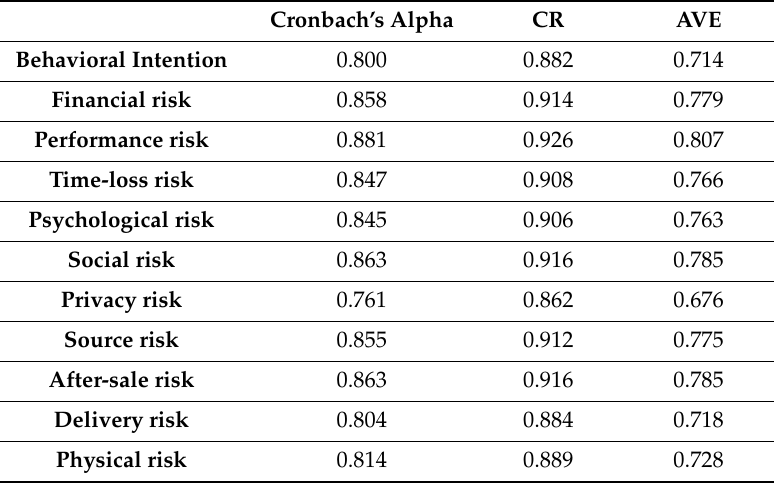
Table A1. Reliability